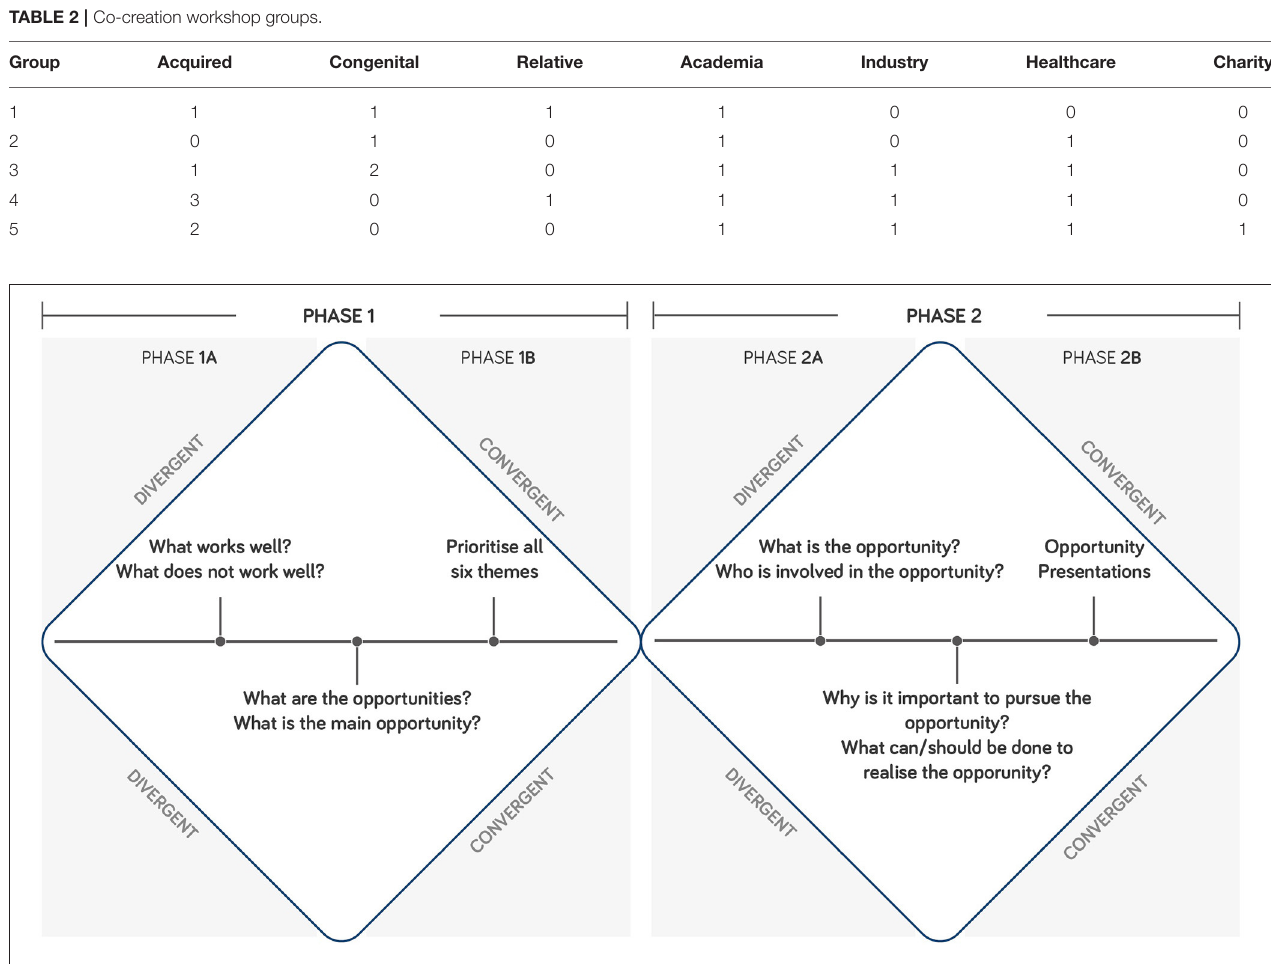
FIGURE 1 | Workshop model, inspired by the Double Diamond Model by the Design Council